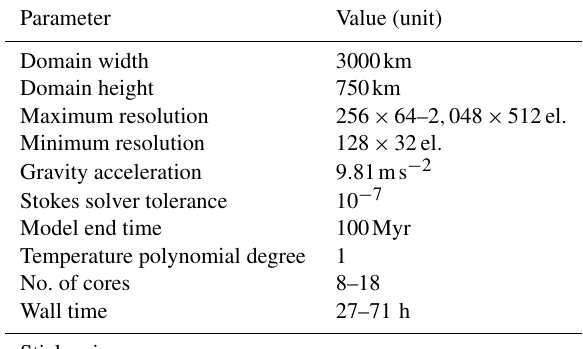
Table A1. The self-consistent subduction benchmark model param- eters.